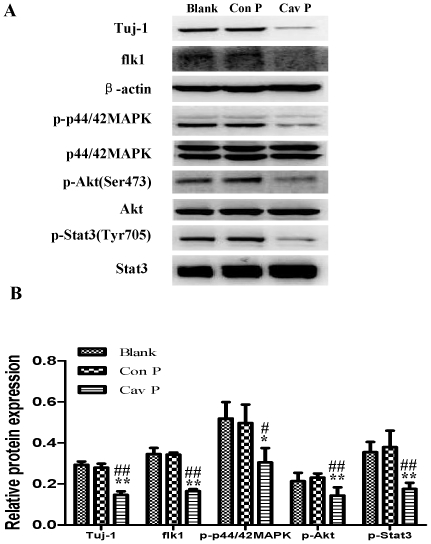
Effects of Cav-1 scaffolding domain peptide on the expressions of Tuj-1, flk1, p-p44/42MAPK, p-Akt and p-Stat3 proteins in NPCs under normoxic condition.Similar protocols as Figure 7 were used. Expressions of Tuj-1, flk1, p-p44/42MAPK, p-Akt and p-Stat3 proteins in NPCs at day 14 were analyzed with western blot analysis. Cell lysates were blotted with the antibodies of Tuj-1, flk1, p-p44/42MAPK, p-Akt, and p-Stat3, in which β-actin, p44/42MAPK, Akt and Stat3 were used as internal references, respectively. A. Representative immunoblot results of Tuj-1, flk1, p-p44/42MAPK, p-Akt and p-Stat3. Blank, blank control group; Con P, Cav-1 scrambled control peptide group; Cav P, Cav-1 scaffolding domain peptide group. B. Statistical analysis on the expressions of Tuj-1, flk1, p-p44/42MAPK, p-Akt and p-Stat3 (Mean ± S.D., n = 3). The expressions of Tuj-1 and flk1 were presented as fold activation of light units normalized to β-actin, whereas the phosphorylations of p44/42MAPK, Akt, and Stat3 were presented as fold activations of light units normalized to p44/42MAPK, Akt and Stat3, respectively. Cav P versus blank, * p<0.05, ** p<0.01; Cav P versus Con P, # p<0.05, ## p<0.01; Each sample was assayed at least 3 times.